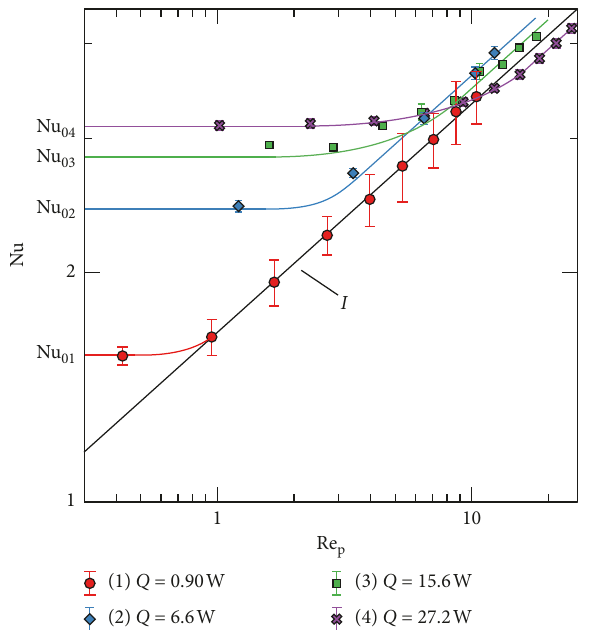
Figure 6: The dependence of Nu on the pulsation Reynolds . The experimental series correspond to the following number Re p ranges of Ra · 10 − 3 : 1 . 1 − 2 . 6 (1), 9 . 1 − 15 (2), 27 − 40 (3), and 64 − 93 (4), and to the following ranges of ω : 31 . 3 − 32 . 4 (1), 36 . 7 − 41 . 0 (2), 46 . 3 − 55 . 6 (3), and 62 . 0 − 79 . 0 (4). Values of Nu � at Re p